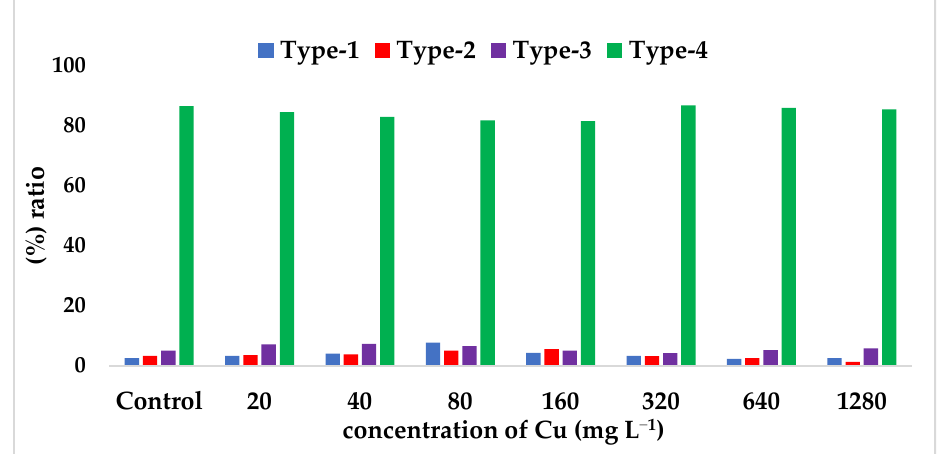
Figure 2. The average rates of methylation types based on CRED-RA data analysis in the root tissues of safflower seedlings after exposure to increasing Cu concentrations (20–1280 mg L − 1 CuSO 4 ·5H 2 O) for 21 days, compared to the control group (containing 0 mg L − 1 Cu and irrigated only with Hoagland solution).